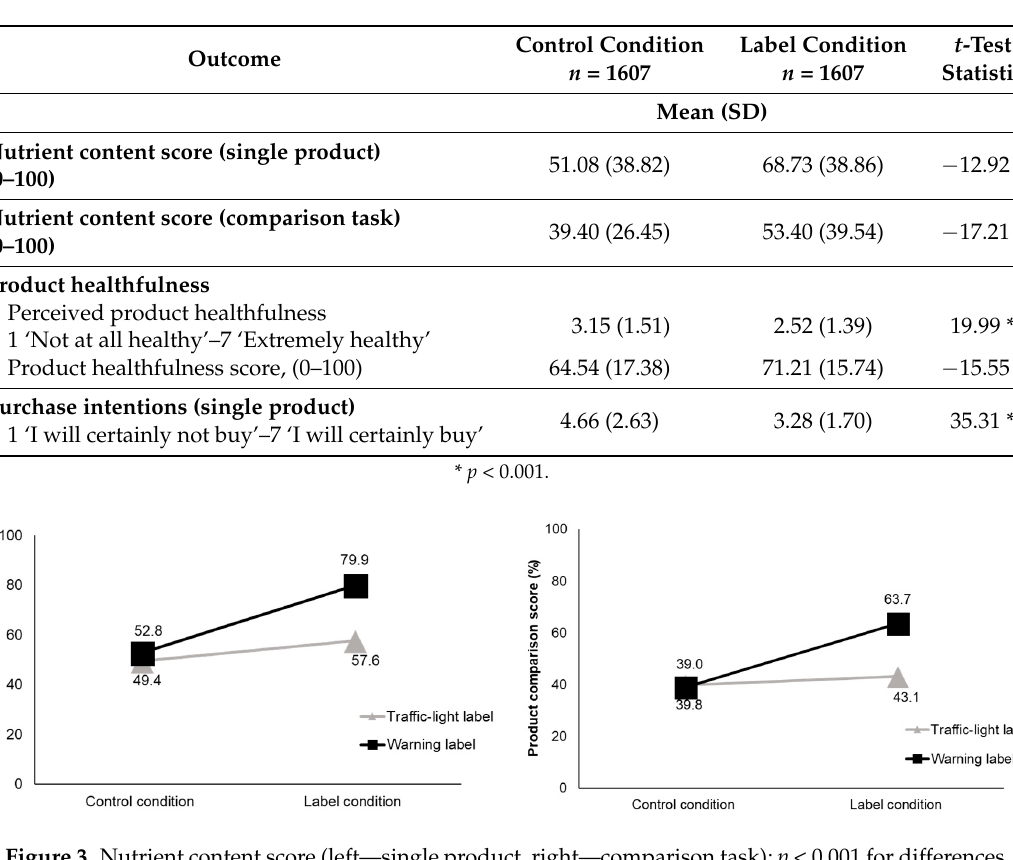
Figure 3. Nutrient content score (left—single product, right—comparison task); p < 0.001 for differences between label conditions at T2. Table 4. Performance on study outcomes between traffic-light label and warning label